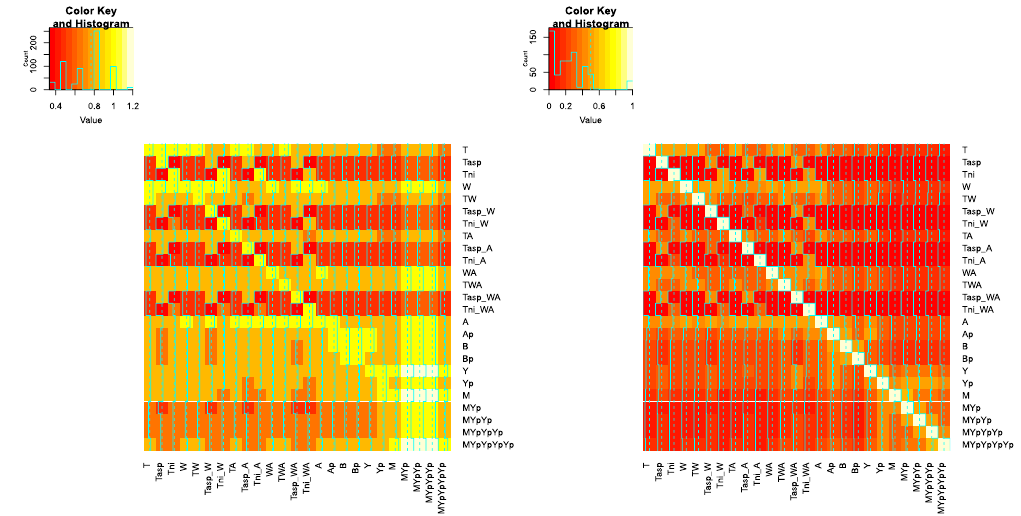
Figure 5. Heatmaps of the BioModel (left) and sparse graph model (right) on BIOMD0000000404